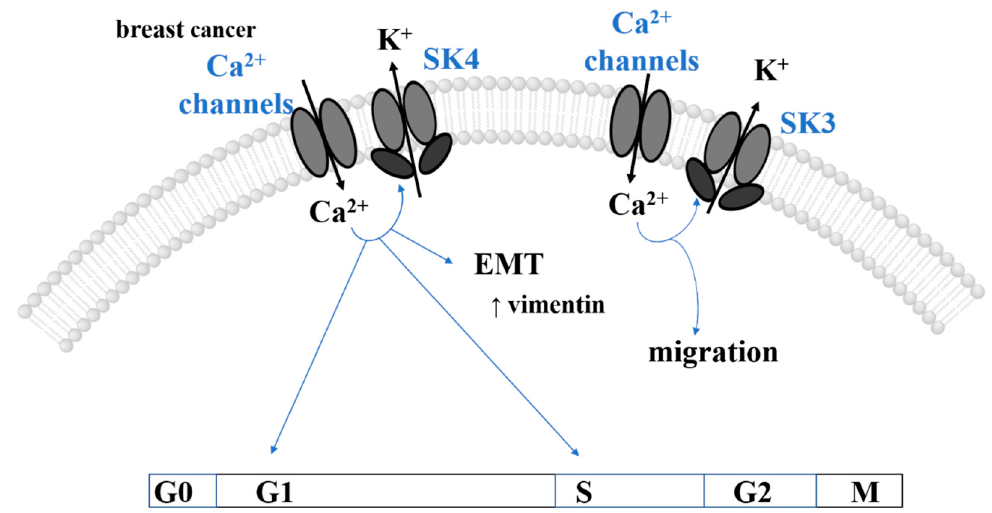
Figure 7. Cancer features and associated SK channel-dependent signaling pathways in different cancer types. The scheme summarizes the current knowledge of signaling pathways controlling cancer features (proliferation and EMT/migration) of the mentioned cancer types depending on SK channels as well as Ca 2+ signaling. Software used for all figure drawings: Procreate, Chemdraw (RRID:SCR_016768).